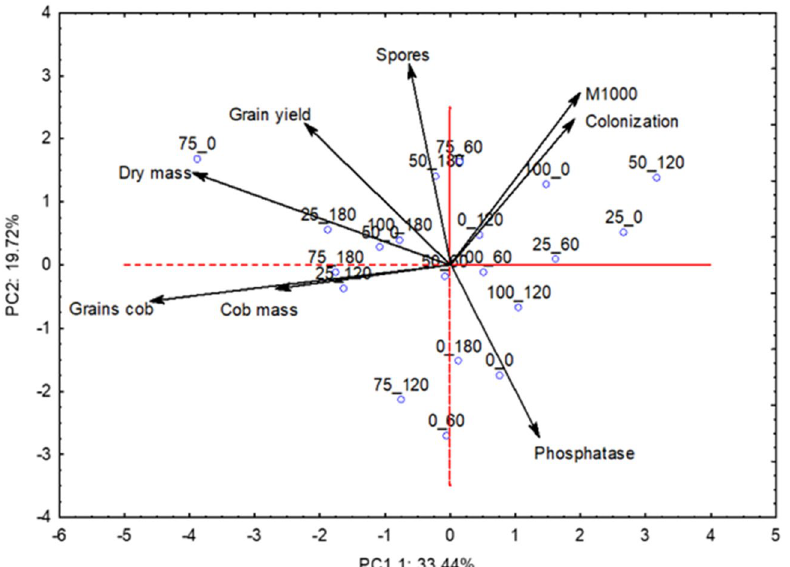
Figure 2. Biplot graph for the principal components PC1 and PC2 in the principal component analysis with amounts of P 2 O 5 and inoculant containing Rhizophagus intraradices in 2020 season. PC1 = principal component one; PC2 = principal component